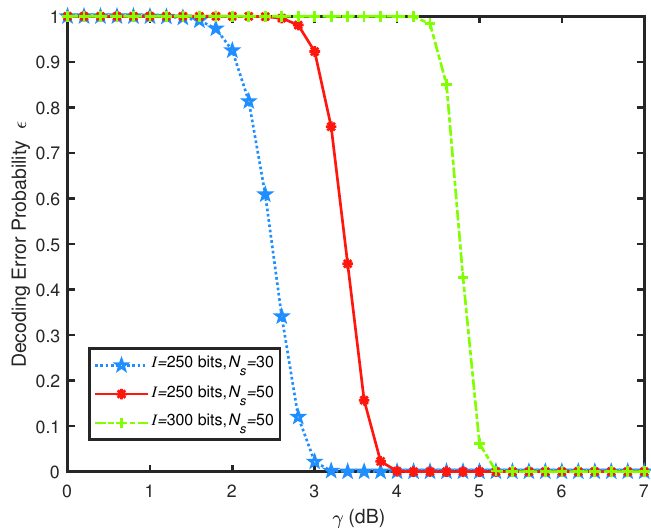
Figure 5. Decoding error probability versus the SNR for different I and N s